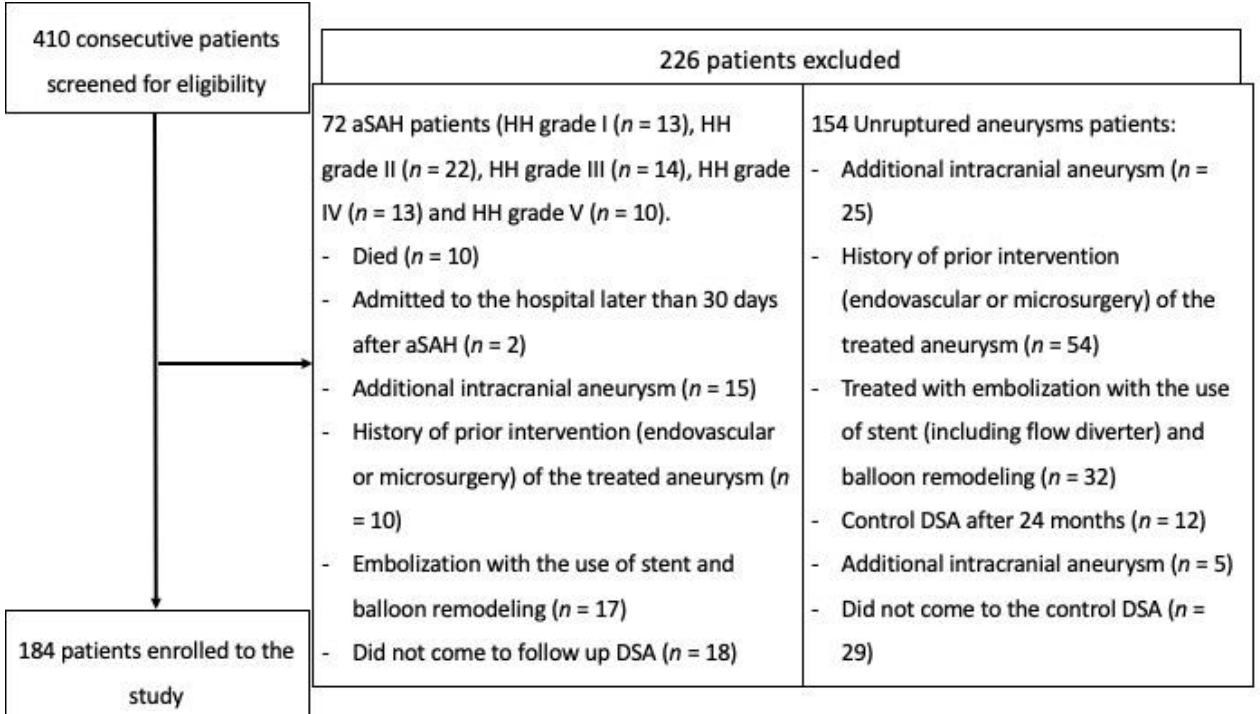
Figure 2. Flowchart presenting the enrollment of the patients.